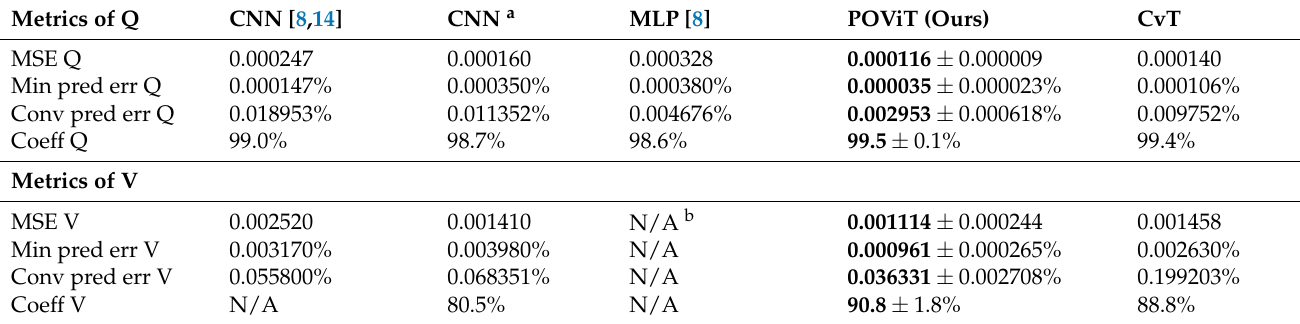
Table 1. Comparison of performance metrics for Q and V across several models: CNN, MLP, POViT (ours), and CvT. Conv stands for converged. Coeff values are rescaled to percentages. All the data, except for those cited, are calculated in the process of producing this work. Except for POViT, which records mean values with uncertainties, data for all the other models are best/optimal values. Raw data used for generating this table are displayed in Table S3 in the Supplementary